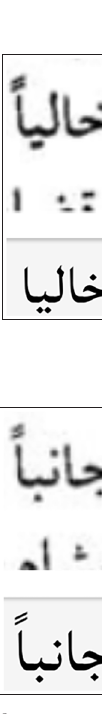
Figure 17: Correctly transcribed fat